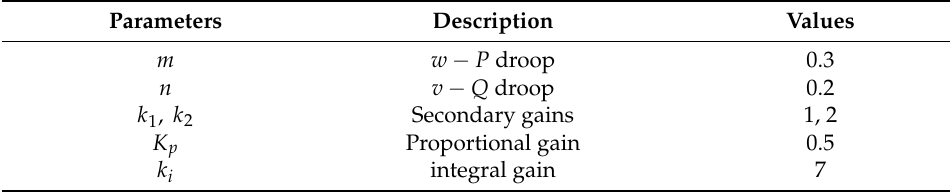
Table 2. Controller